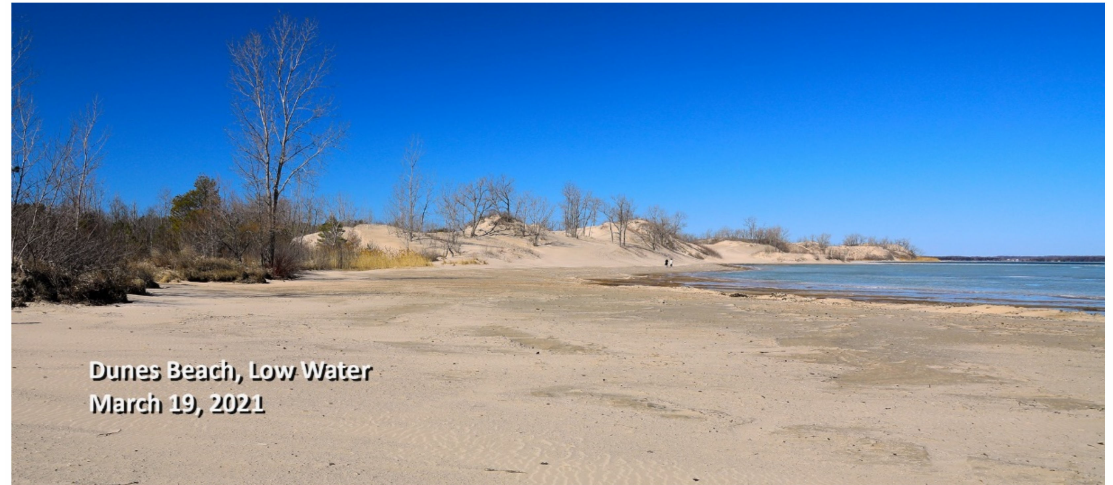
Figure 10. Low water level in West Lake (Photo by: John A. Brebner, 2021 @friendsofsandbanks on